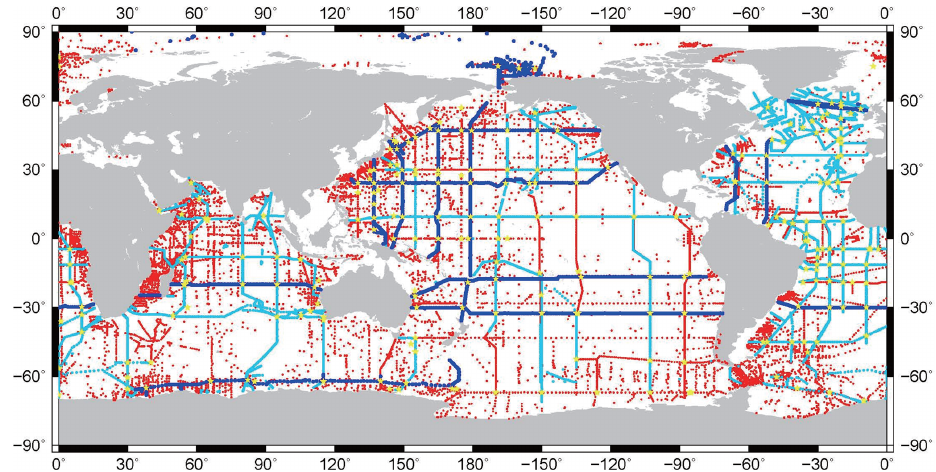
Figure 1. Sampling locations where nitrate concentrations were measured and tracks of cruises that measured nitrate concentrations. Dark blue: category 1 cruises with CRM/RM or equivalent quality control. Light blue: category 2 cruises, WOCE/GO-SHIP cruises, but no CRM/RM used. Red: cruises in categories 3–7. Yellow points are crossover points.